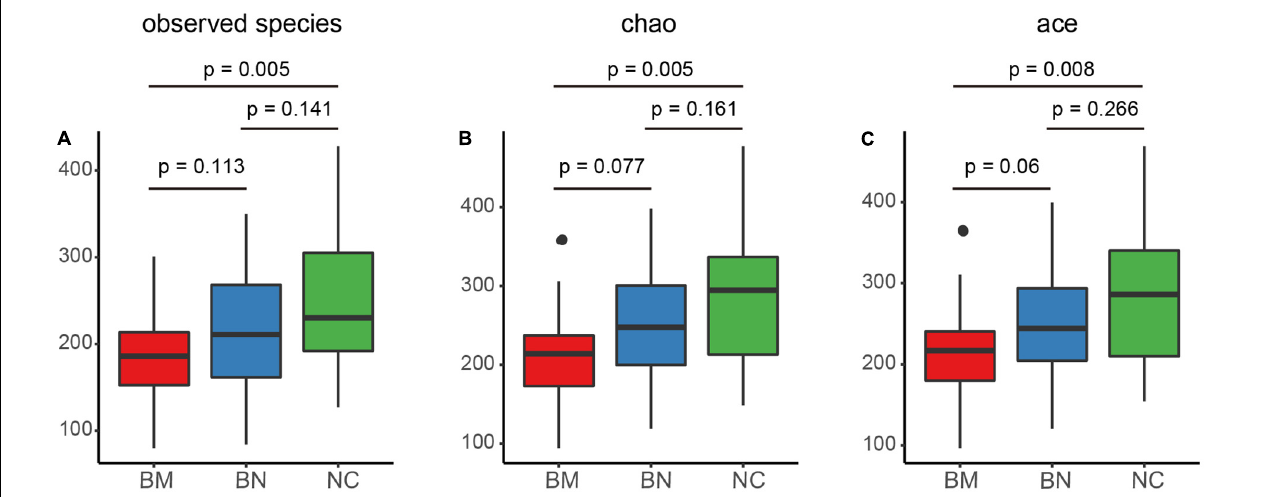
FIGURE 1 | Comparison of the gut microbiota alpha and beta diversity indexes of NCs, BNs, and BMs. (A–C) Box plots comparing the alpha diversity of NCs, BNs, and BMs using observed species (A) , Chao (B) and ACE (C) indexes. NCs, normal controls; BNs, breast cancer patients with no metastasis; BMs, breast cancer patients with bone metastasis. P values were calculated using the Kruskal–Wallis